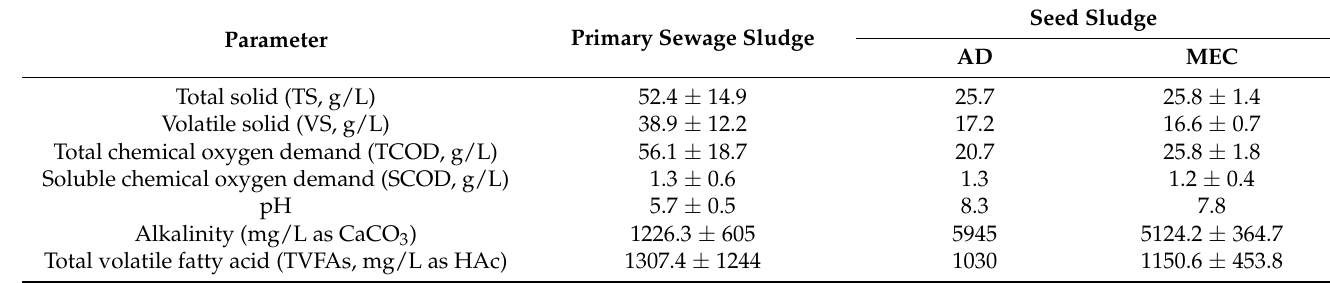
Table 1. Characteristics of the primary sewage sludge, AD and MEC seed